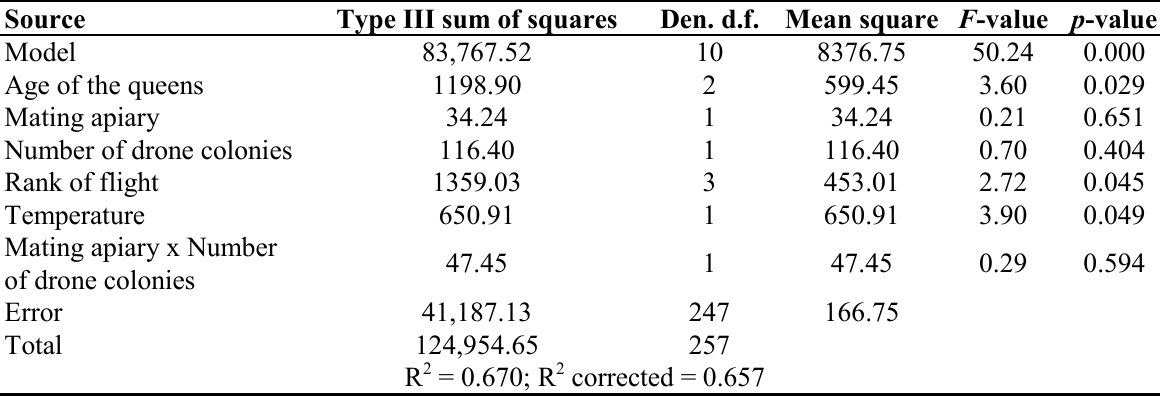
Table 5. Effects of queen’s age, mating apiary, number of drone colonies, rank of consecutive flights and temperature (at departure; included as a covariate) on the duration of the nuptial flights. Type III sum of squares, denominator degrees of freedom (Den. d.f.), mean square, F -value and p -value are given for each factor.